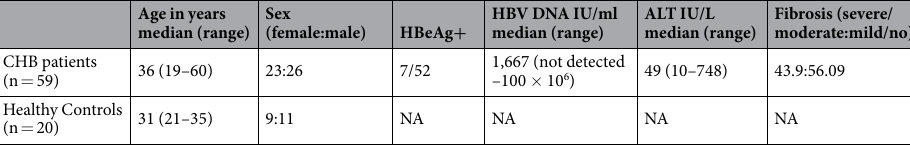
Table 1. Clinical characteristics of CHB patients and healthy